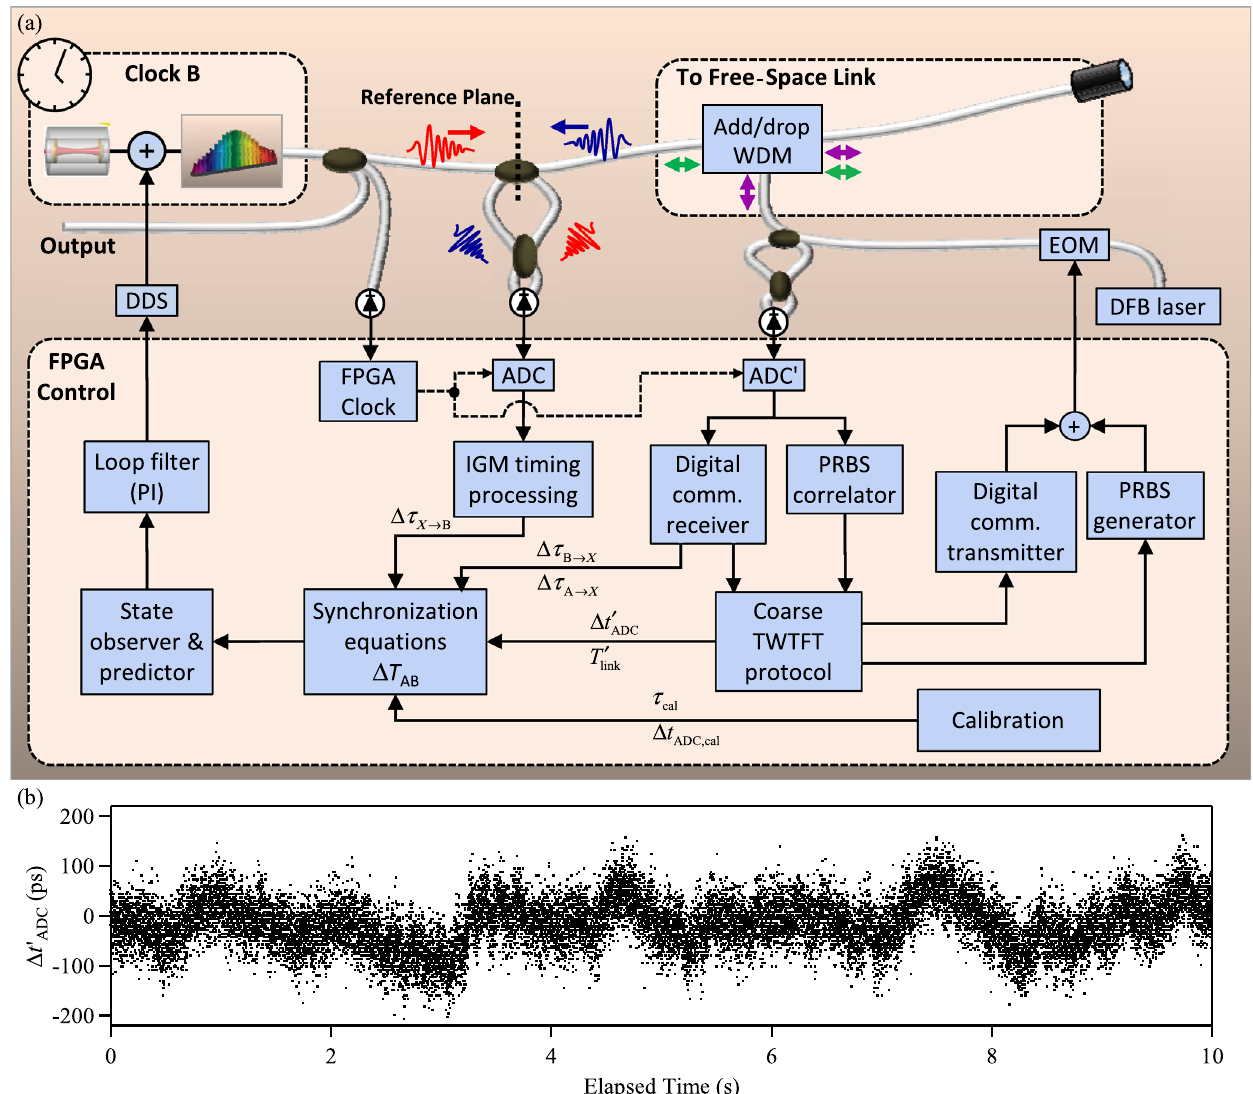
FIG. 9. (a) Detailed schematic of system on site B that defines the various quantities relevant to the calibration and to the calculation of the master synchronization equation. See text for details. DDS, direct digital synthesizer; PRBS, pseudorandom binary sequence; ADC, analog-to-digital converter for the linear optical sampling between comb pulse trains; ADC 0 , analog-to-digital converter for the coarse two-way time transfer via the PRBS signals; DFB, distributed feedback laser; EOM, Electro-optic phase modulator; PI, proportional- integral loop filter; WDM, wavelength division multiplexer; IGM, interferograms. TWTFT, two-way time-frequency transfer. (b) Time synchronization between the ADC clocks of the remote and master sites with a standard deviation of below 57 ps. (Longer duration data have the same standard